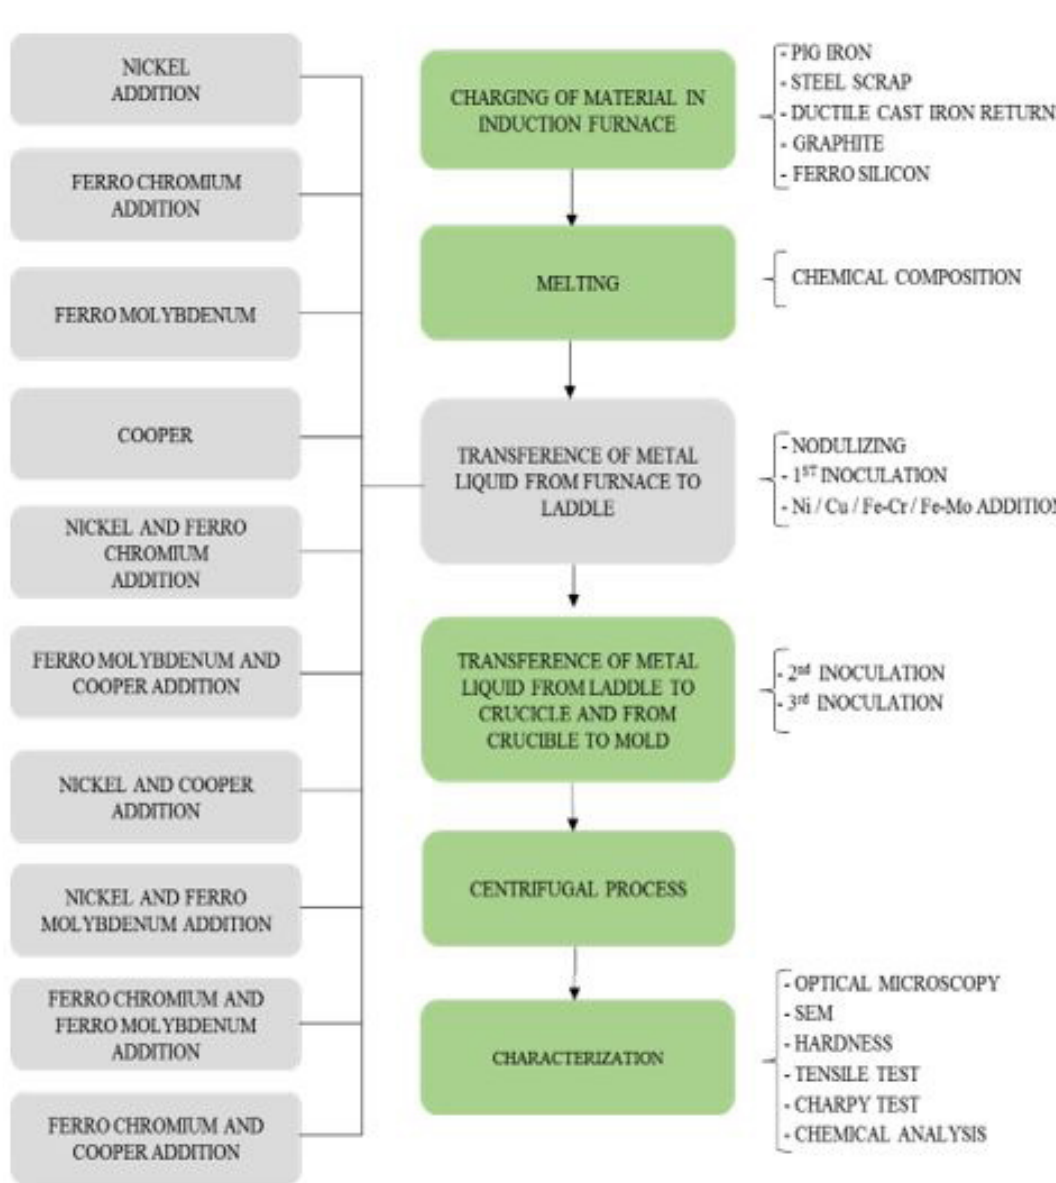
Figure 1. Route used for ductile cast iron